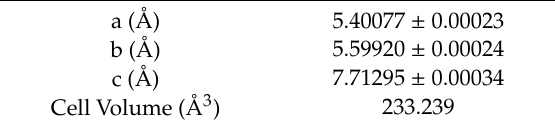
Table 1. Lattice parameters of SmFeO 3 nanopowder.